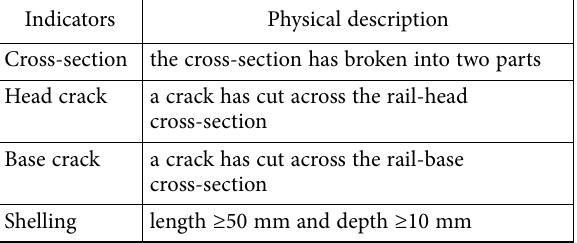
Table 3. Standards for broken rail defects